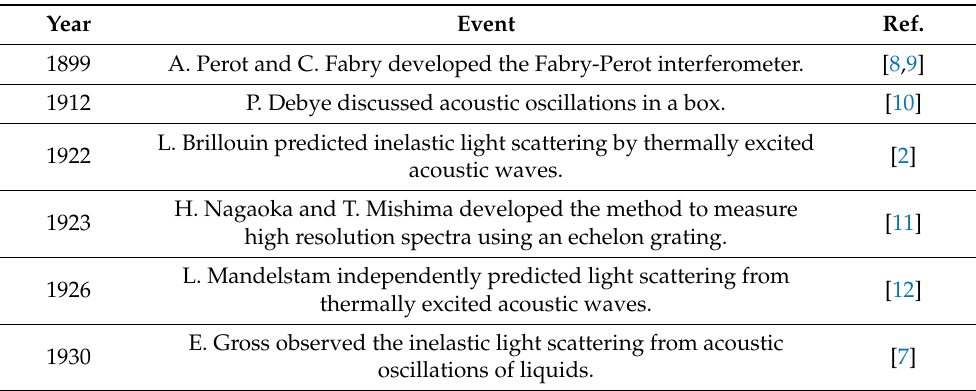
Table 1. History timeline related to Brillouin scattering in the early days.